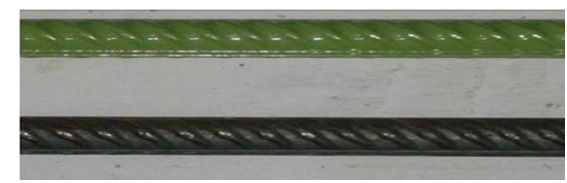
Figure 2. Deformation Pattern of reinforcing bars.